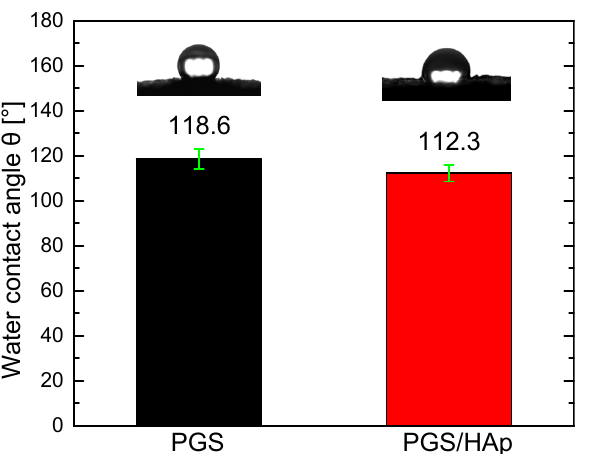
Figure 6. Water contact angle measurement (mean value ± SD) for the PGS and PGS/HAp scaffolds.